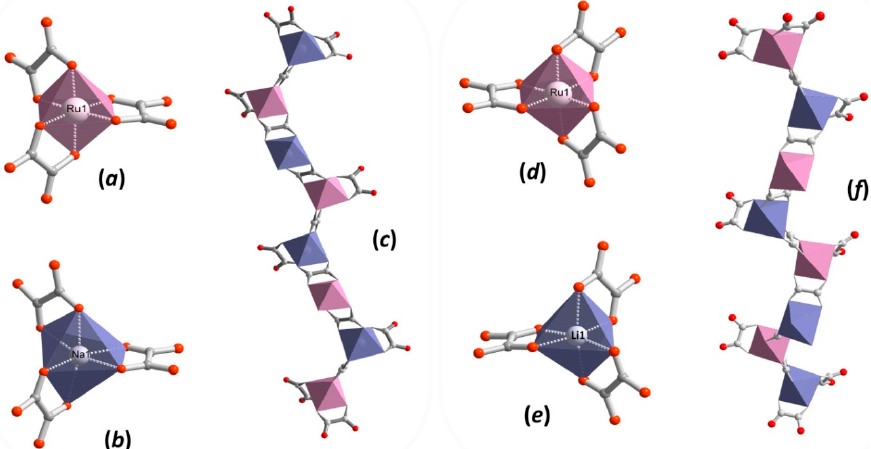
Figure 1. Representation of octahedral coordination environments of ( a ) Ru III and ( b ) Na I in 1 exhibiting Λ -conformation with the corresponding ( c ) left-handed helix substructure formed. Representation of octahedral coordination environments of ( d ) Ru III and ( e ) Li I in 1 exhibiting ∆ -conformation with the corresponding ( f ) right-handed helix substructure formed. Red and grey spheres represent oxygen and carbon atoms, respectively.